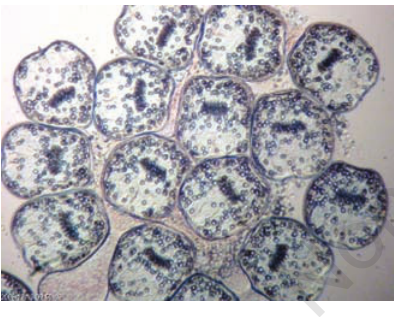
eosin.Figure 1. Live protoscolices after staining with 0.1% eosin.